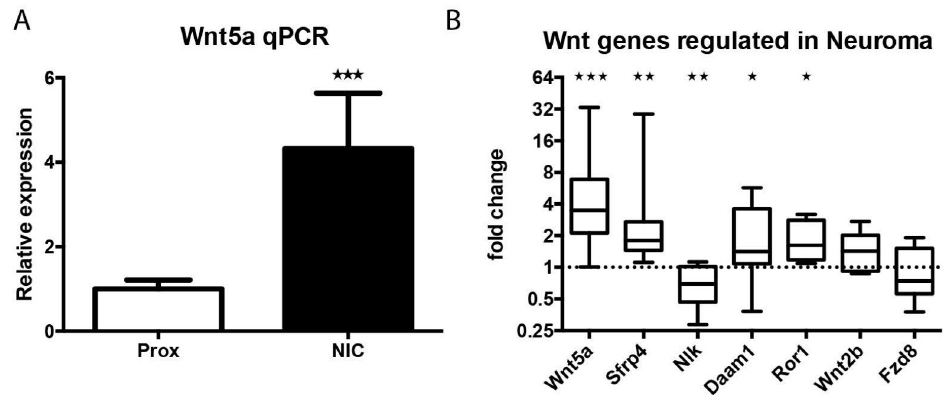
Fig 1. Specific Wnt pathway genes are differentially expressed in human NIC. A , qPCR analysis shows that 5 months after injury human NIC tissue has increased levels of Wnt5a mRNA compared to the proximal stump. B , in addition to Wnt5a (p < 0.001), qPCR analysis shows that extracellular Wnt modulator Sfrp4, Wnt pathway member Daam1 and the Wnt receptor Ror1 are upregulated. Wnt pathway member Nlk is down regulated. Wnt receptor Fzd8 and Wnt ligand Wnt2 are not differently expressed between the NIC and the proximal stump ( � p < 0.05, �� p < 0.01, ��� p <